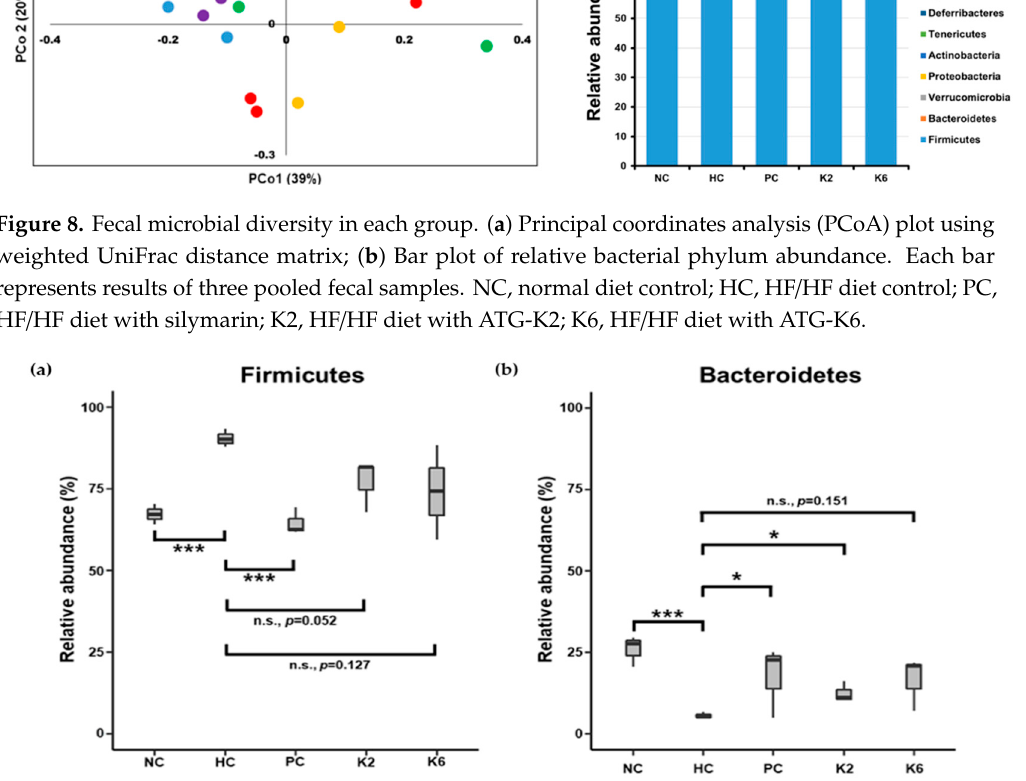
Figure 9. Relative abundance of phyla ( a ) Firmicutes and ( b ) Bacteroidetes in each group. Each box plot represents results of three pooled fecal samples. NC, normal diet control; HC, HF / HF diet control; PC, HF / HF diet with silymarin; K2, HF / HF diet with ATG-K2; K6, HF / HF diet with ATG-K6. * p < 0.05, *** p < 0.005, n.s., not significant versus the HC group. Student’s t-test was used to compare the group means.